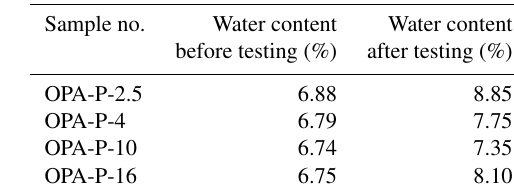
Table 1. Water content of samples before and after the experiment indicating the re-saturation of the